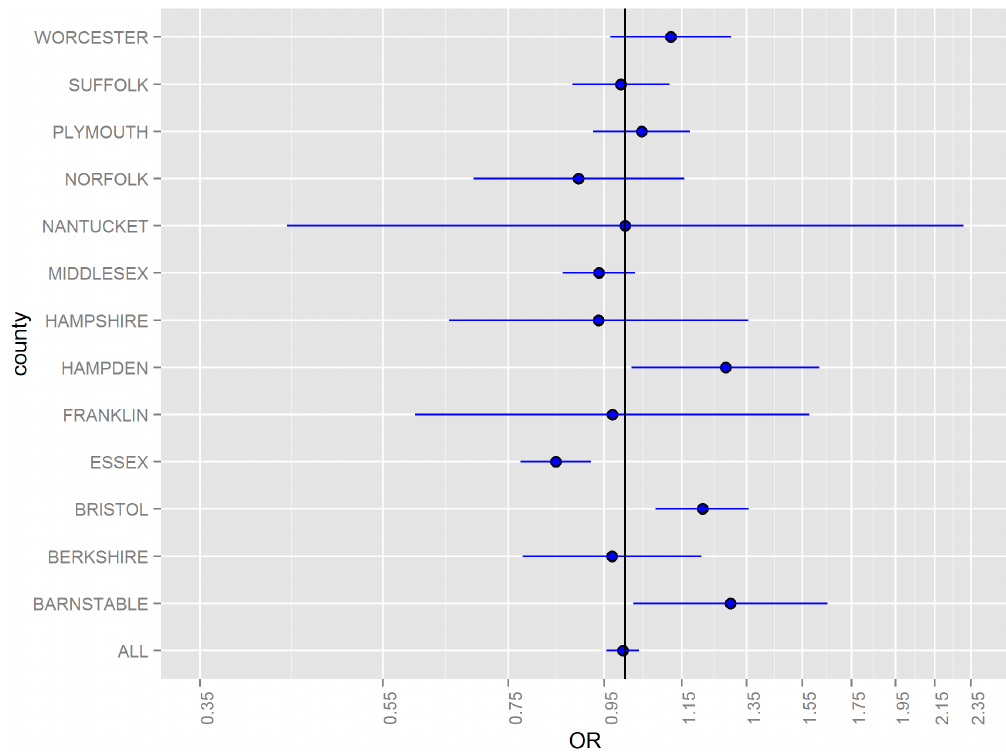
Figure 3. Odds ratios and 95% confidence intervals for emergency room visits for acute gastrointestinal symptoms in the 5–9 days following a flood, 2003–2007.